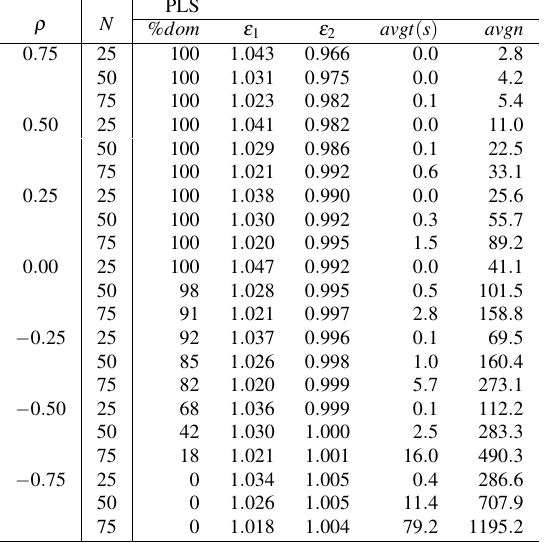
Table 1: W-RoTS dominance over PLS % dom , and binary indicators: ε 1 = I RoTS , PLS ) average running time in seconds avgt ( s ) , and, average number of solutions in the output front avgn .